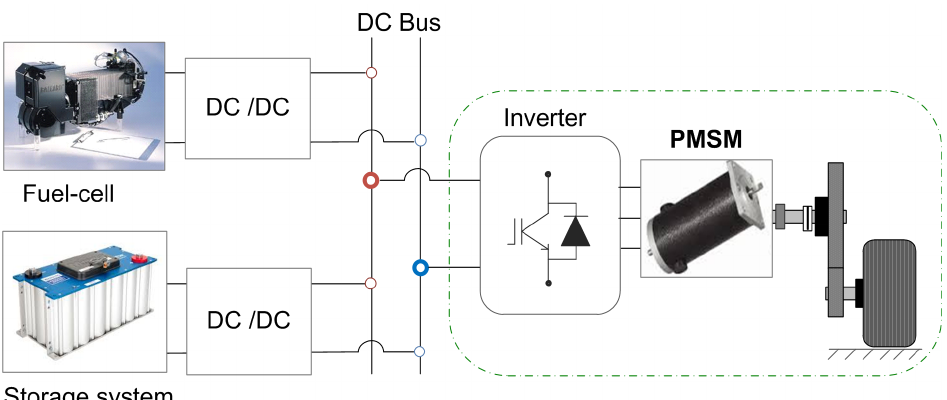
Figure 2. Typical power topology of an electrical vehicle based on PMSM